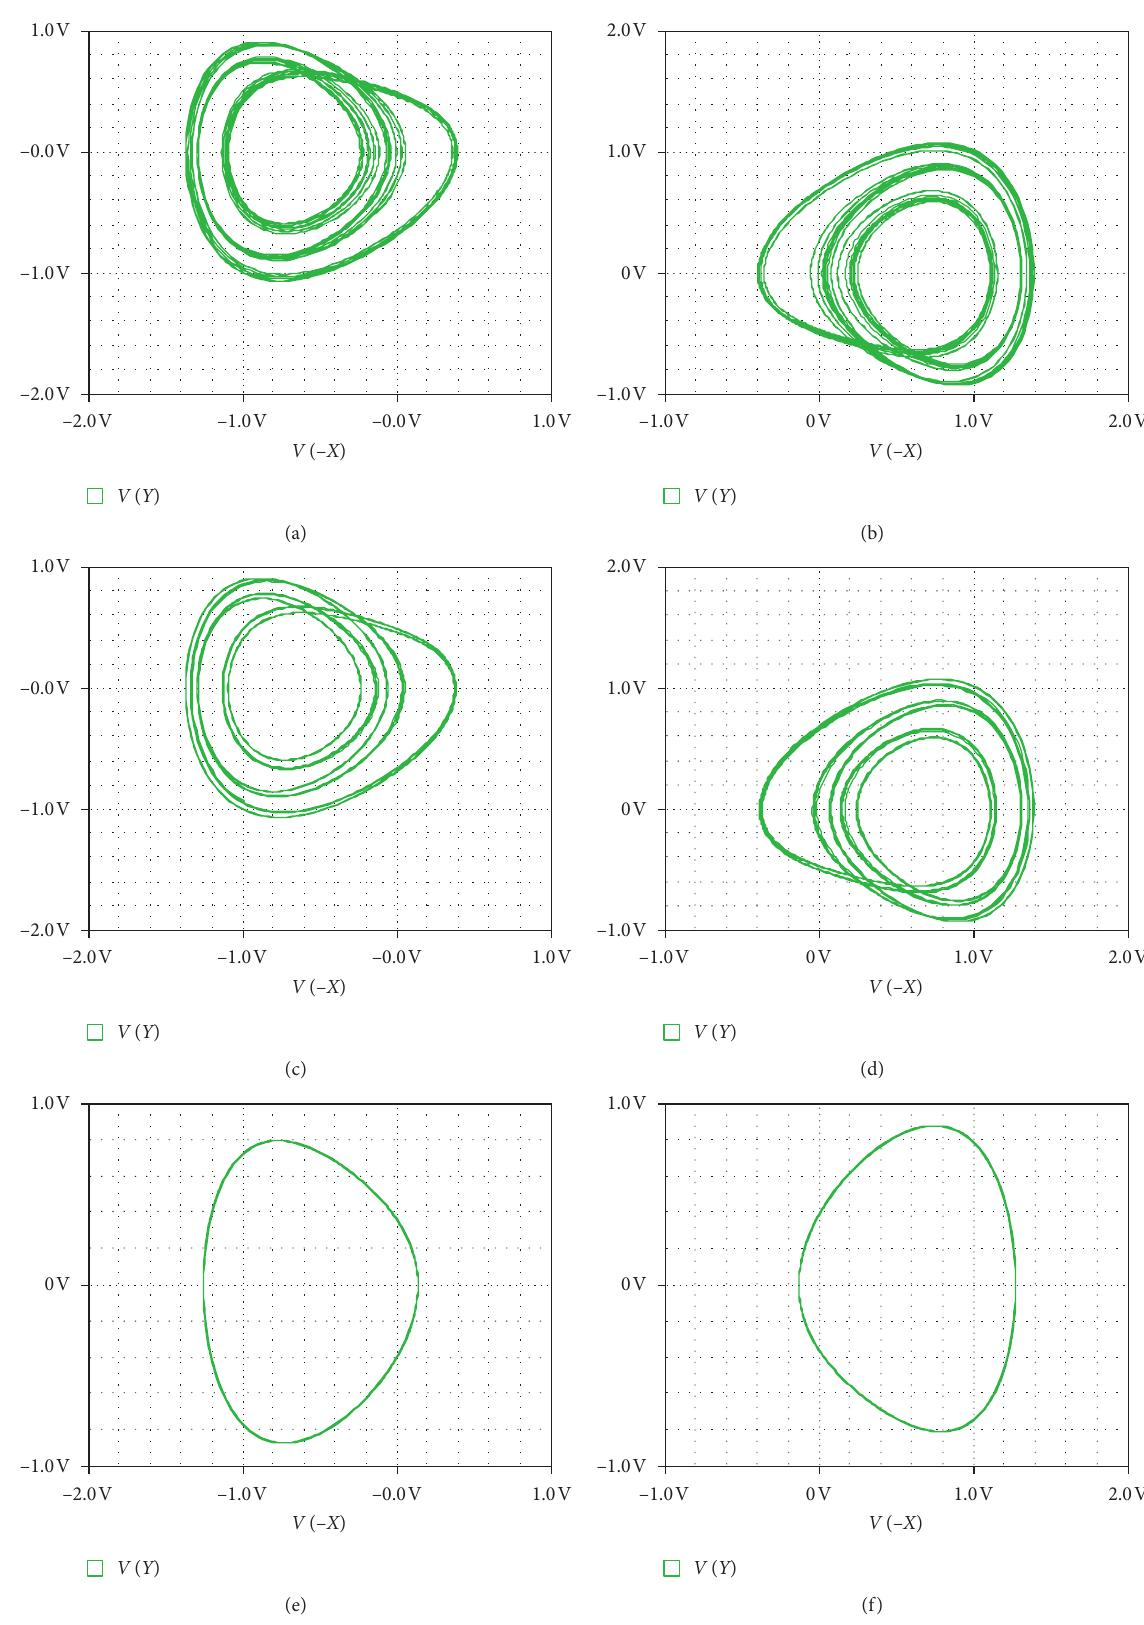
Figure 18: Representation of the six coexistence attractors obtained in PSpice with R initial conditions ( X ( 0 ) ,Y ( 0 ) , Z ( 0 )) : (a) cycle of n-finite period and (b) its symmetry for ( ± 0 . 25 , 0 , 0 ) ; (c) cycle of period-6 and (d) its symmetry for (+ 0 . 17 , 0 , 0 ) and (− 0 , 88 , 0 , 0 ) , respectively; (e) cycle of period-1 and (f) its symmetry for ( ± 0 . 11 , 0 , 0 )